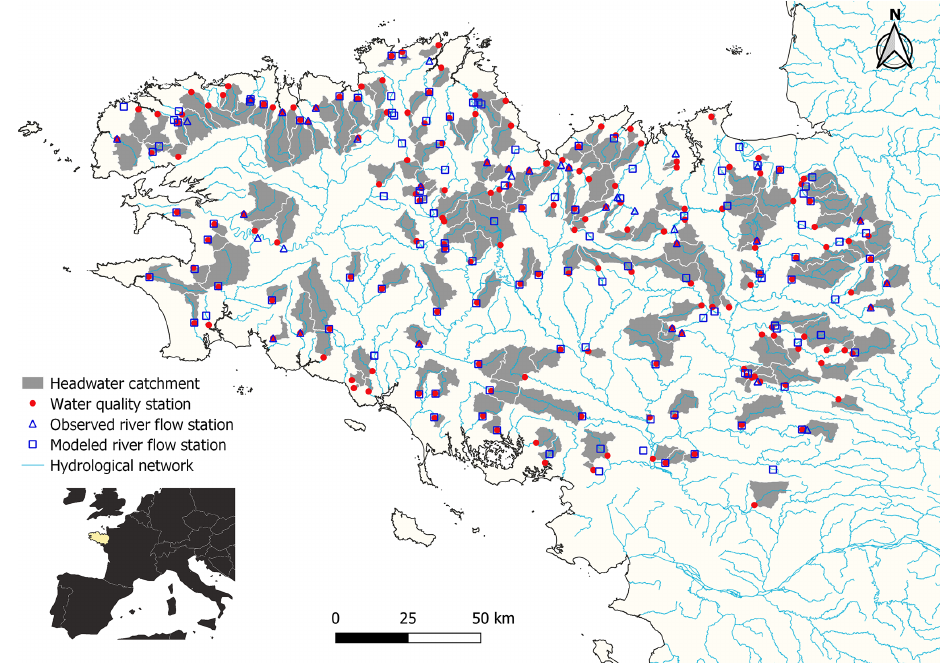
Figure 1. Locations of the 185 study headwater catchments where dissolved organic carbon, nitrate, and soluble reactive phosphorus con- centrations were monitored monthly at the outlet from 2007–2016, and paired discharge stations where daily records of stream flow were available from observations or